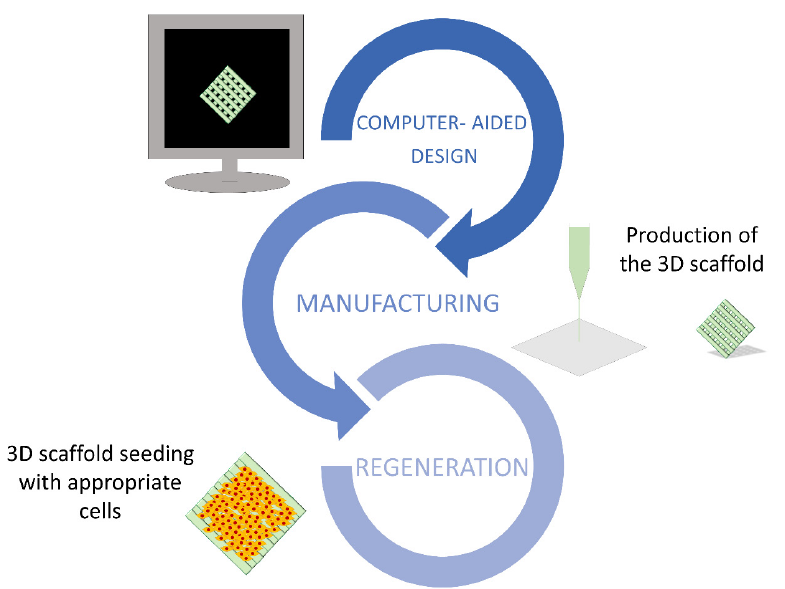
Figure 3. The main fundamental steps needed to construct an artificial organ in vitro. The 3D scaffold shape is modeled using computer-aided design (CAD) software (design). The support is 3D printed after an accurate selection of the most adequate method (manufacturing). Lastly, it is repopulated with the specific cell type/types (regeneration).